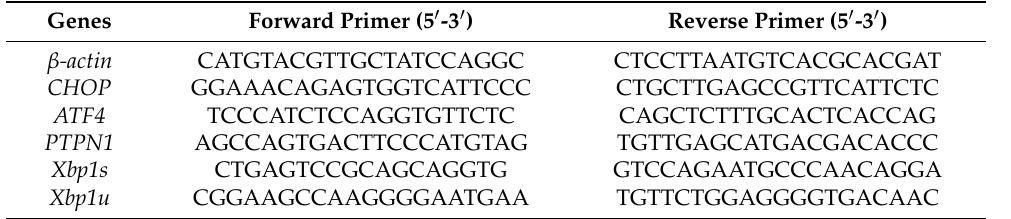
Table 2. Primers designed for quantitative amplification.